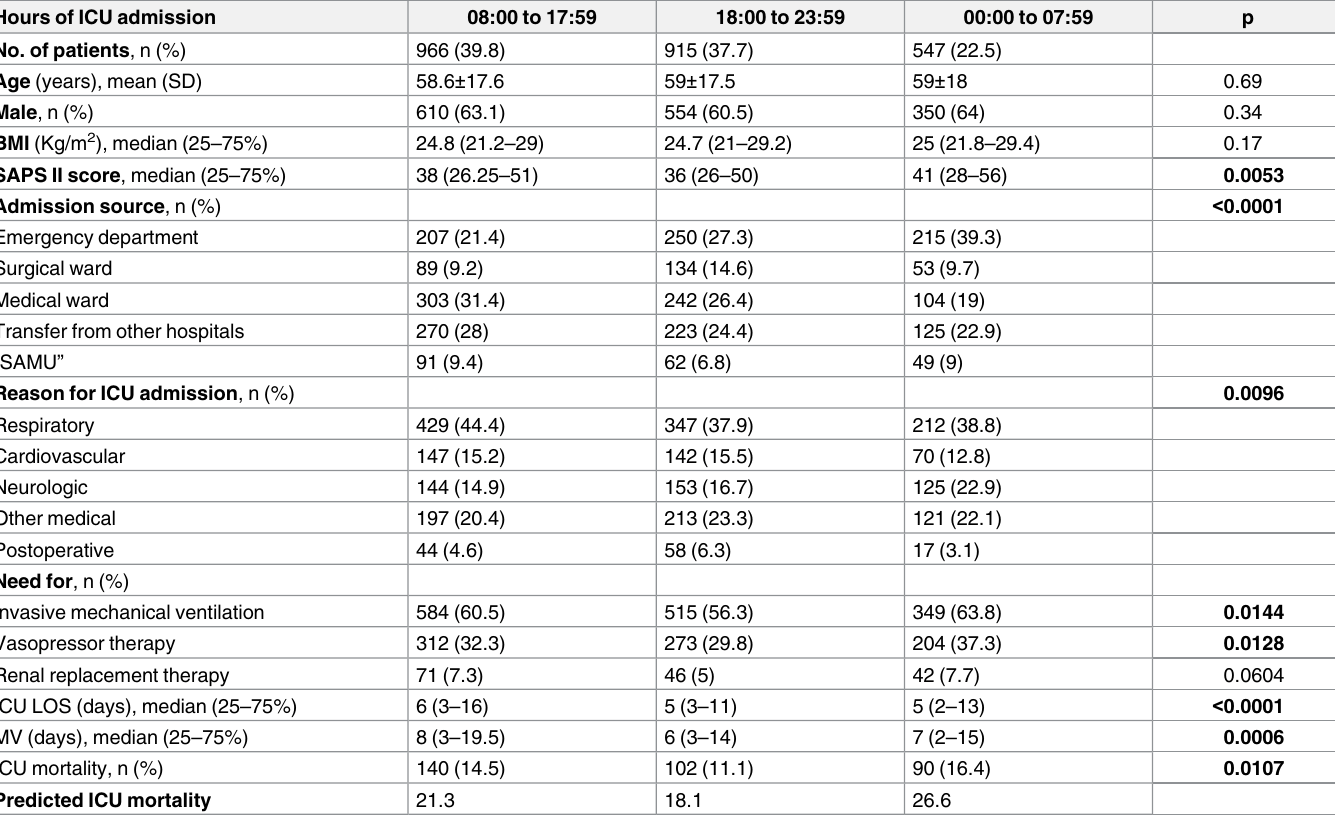
Table 4. Characteristics of patients admitted per time variable regardless of type of the day (working days or not). BMI: body mass index; SAPS II: simplifiedacute physiology score II; ICU: intensivecare unit; LOS: lengthof stay; “SAMU”: S erviced’ A ide M e´dicale U rgente:mobileemergency team; MV: mechanicalventilation. p = significanceas comparedto group admitted from 08:00 to